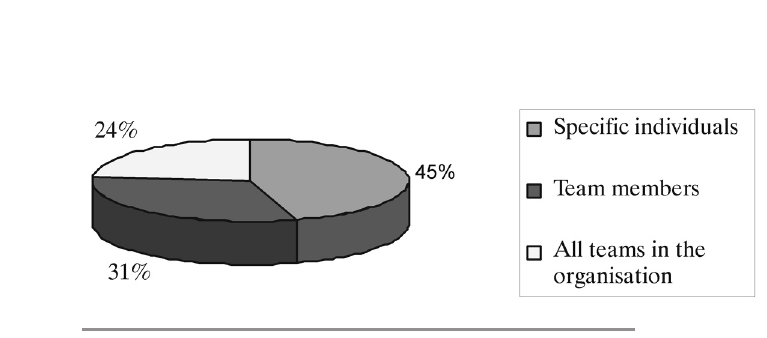
Figure 2 Target of training for R&D staff